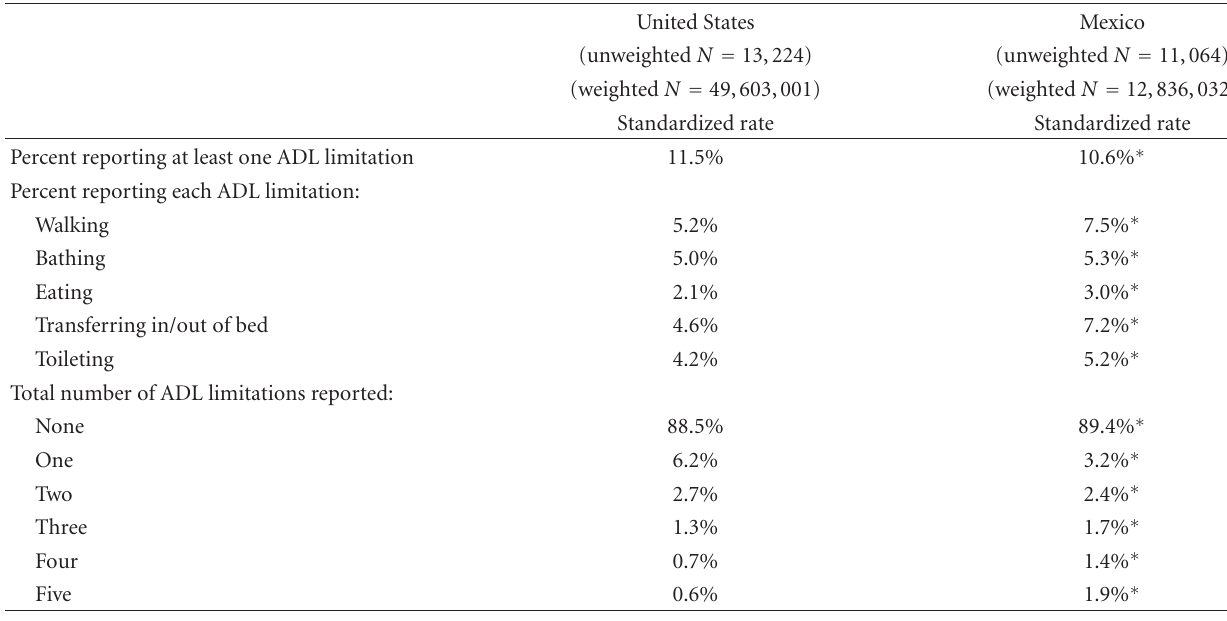
(a) Age-standardized prevalence of ADL limitations at baseline, by country United States